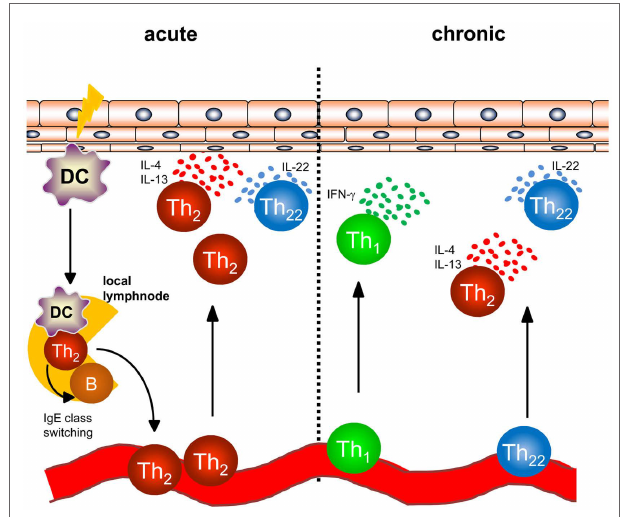
FiGURe 1 | Overview of T helper cell populations in acute and chronic dermatitis . In acute atopic dermatitis activated skin-resident DC migrate to local lymphnodes to prime naïve T helper cells and polarize them into a Th2 phenotype. Th2 cells induce IgE class switching in B cells accounting for enhanced IgE levels regularly found in atopic dermatitis patients. Th2 cells are recruited back to the skin and induce cutaneous inflammation by effector cytokines accompanied by Th22 cells. In chronic atopic dermatitis, Th1 cells are increasingly part of the skin infiltrate consisting of Th1, Th2, and Th22